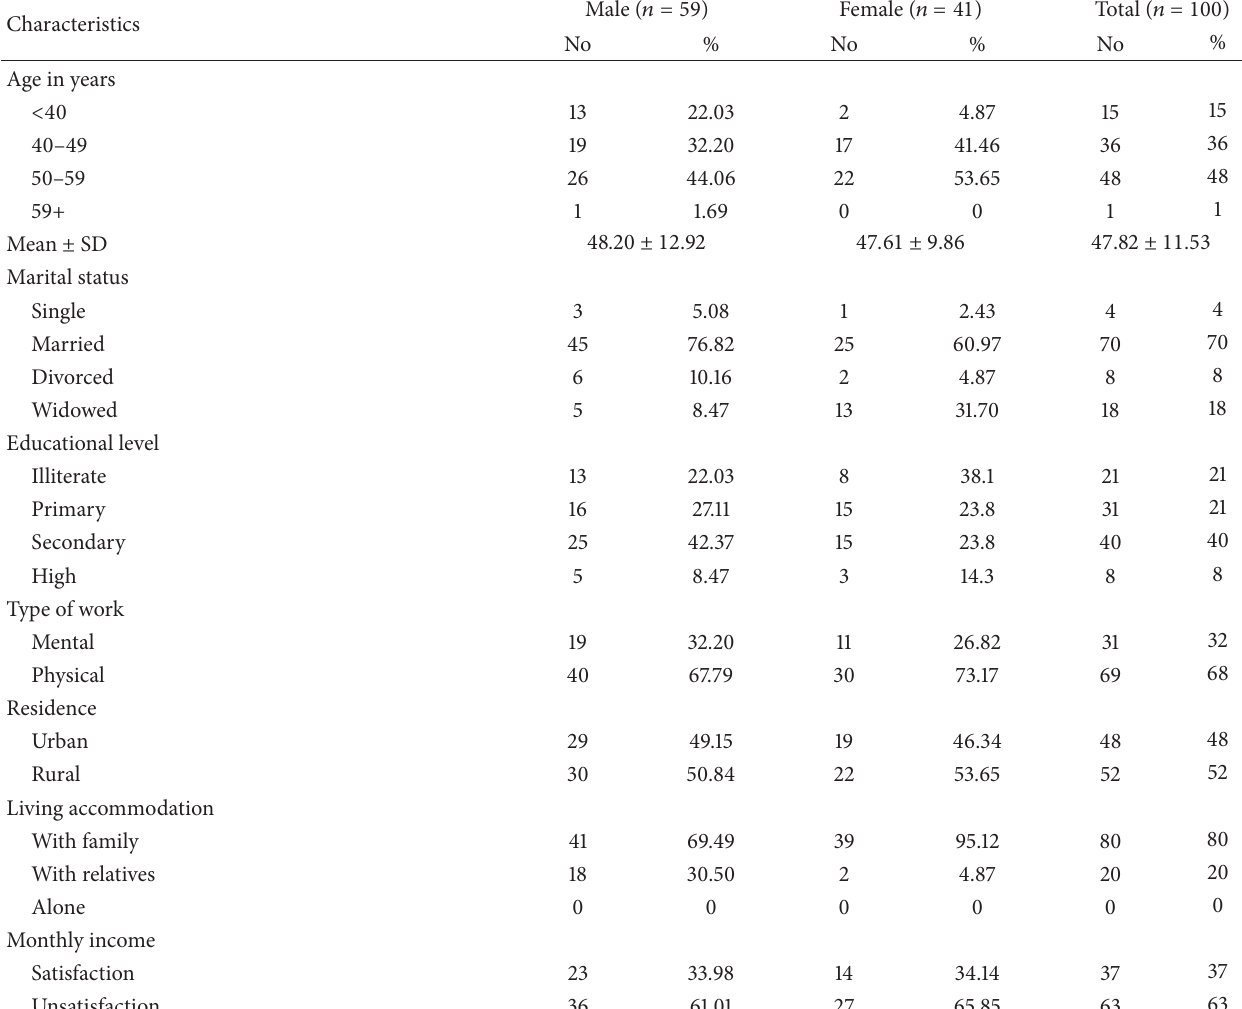
Table 1: Sociodemographic characteristics of the studied amputation patients.